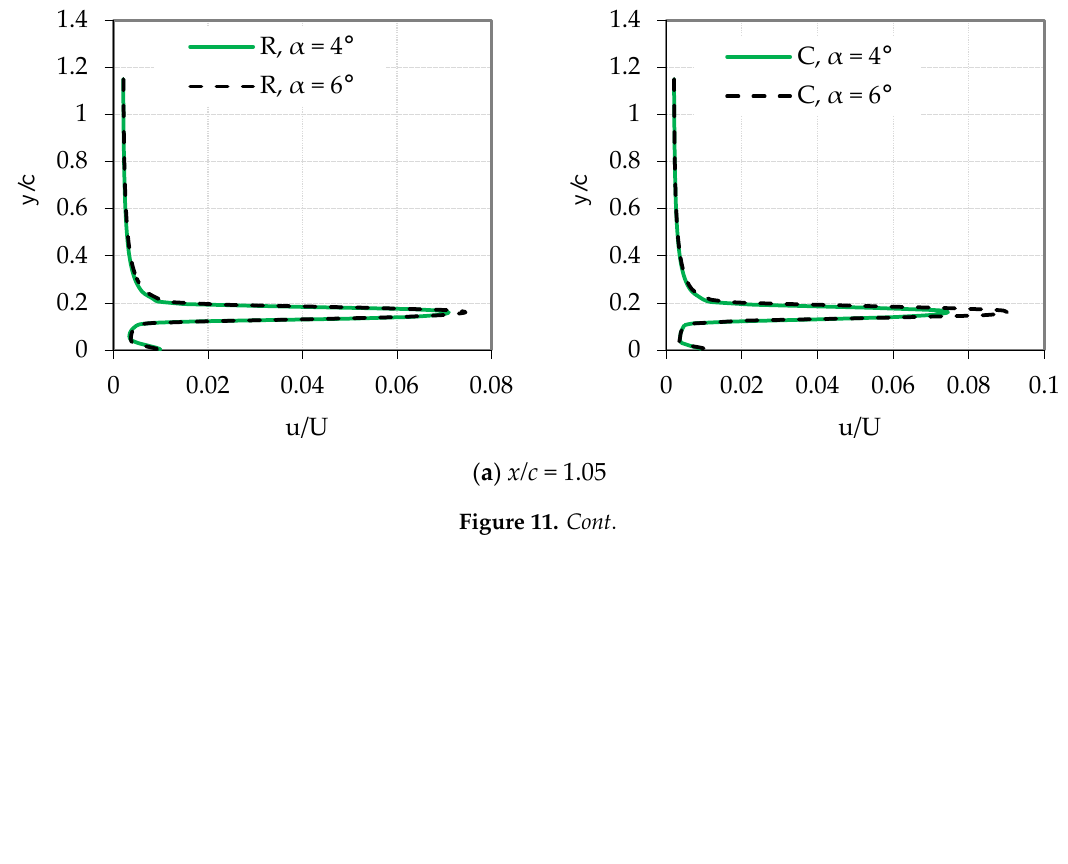
Figure 10. Distribution of the velocity at the middle span in the wake region behind the Compound wing (C) and the Rectangular wing (R) at ( a ) x / c = 1.05, ( b ) x / c = 1.25, ( c ) x / c = 1. 5 and ( d ) x / c = 2.0 for h / c = 0.15 and various angles of attack ( α ). Table 3. Maximum velocity deficiency in the wake area in the back of the compound and the rectangular wing.